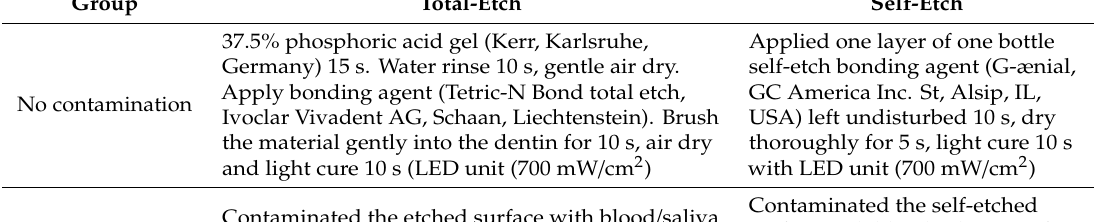
Table 1. Description of the surface treatment and bonding procedure for each subgroup as follows.